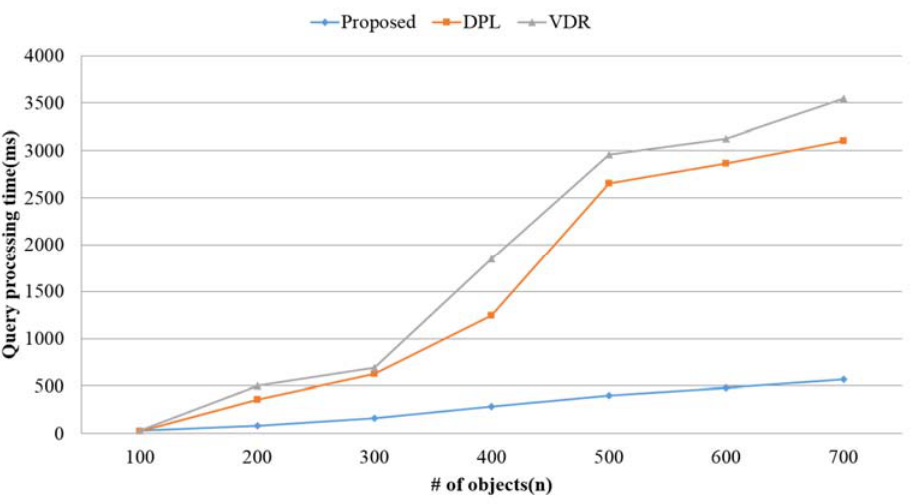
Figure 15. Query-processing time according to number of Figure 15. Query ‐ processing time according to number of objects.